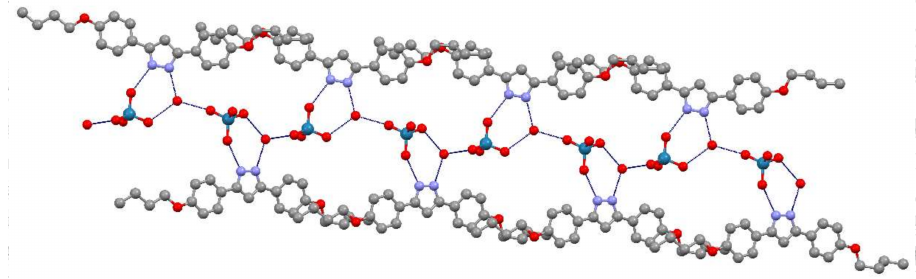
Figure 3. View of the double chain along the b axis (hydrogen bonds are represented in